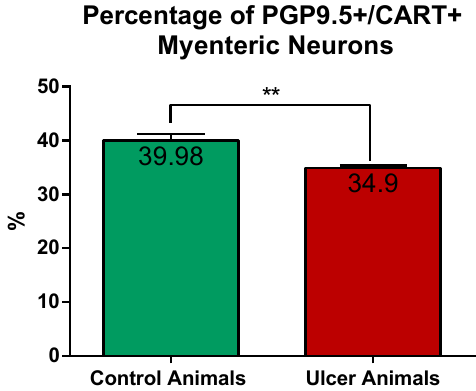
Figure 3. Graph showing the percentage of PGP 9.5/CART double immunofluorescent myenteric perikarya in the control and experimental animals. The number of cells was significantly reduced in ulcer animals. (**) p value = 0.0087.